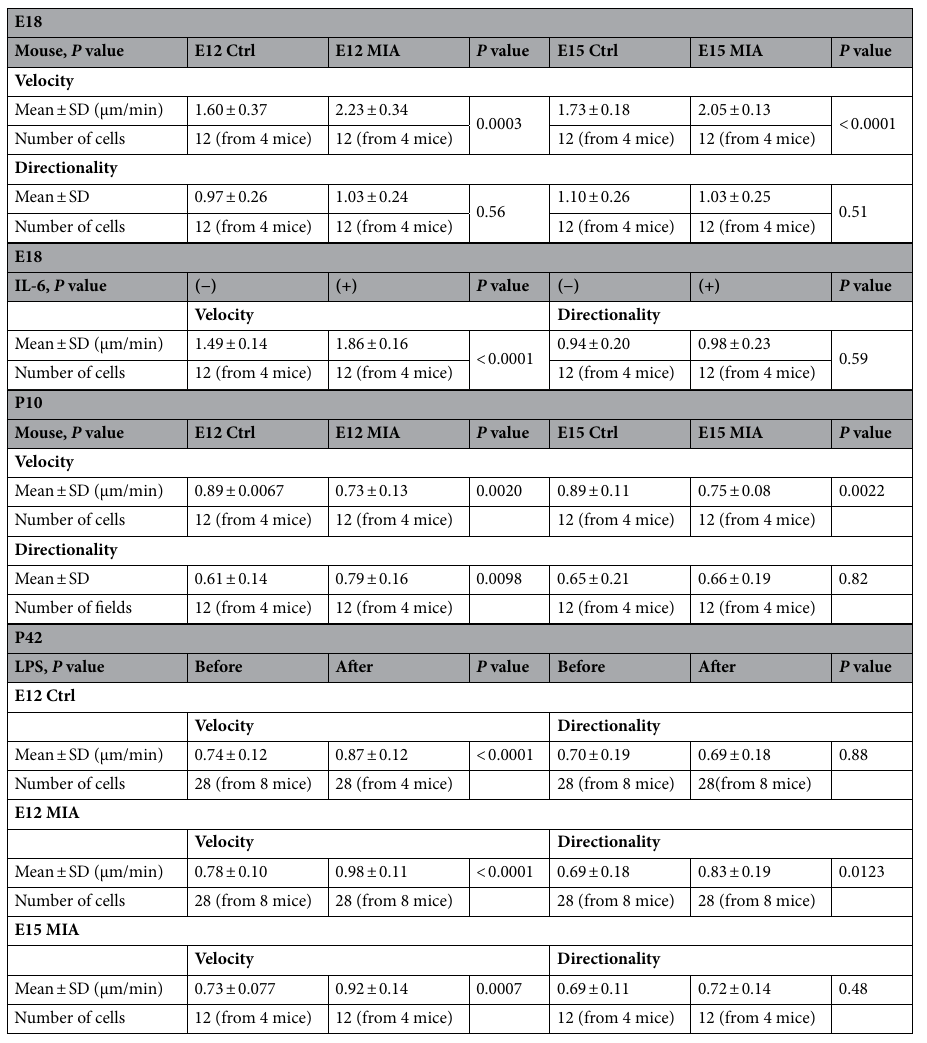
Table 4. Process motility analysis of microglia at E18, P10 and